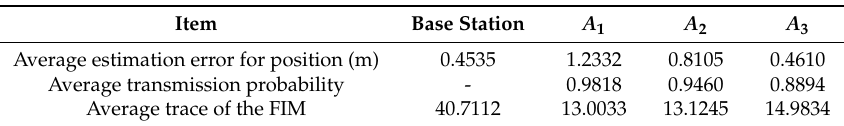
Table 9. The average estimate errors, the average transmission probability, and the average trace of the FIM in Scenario 4.